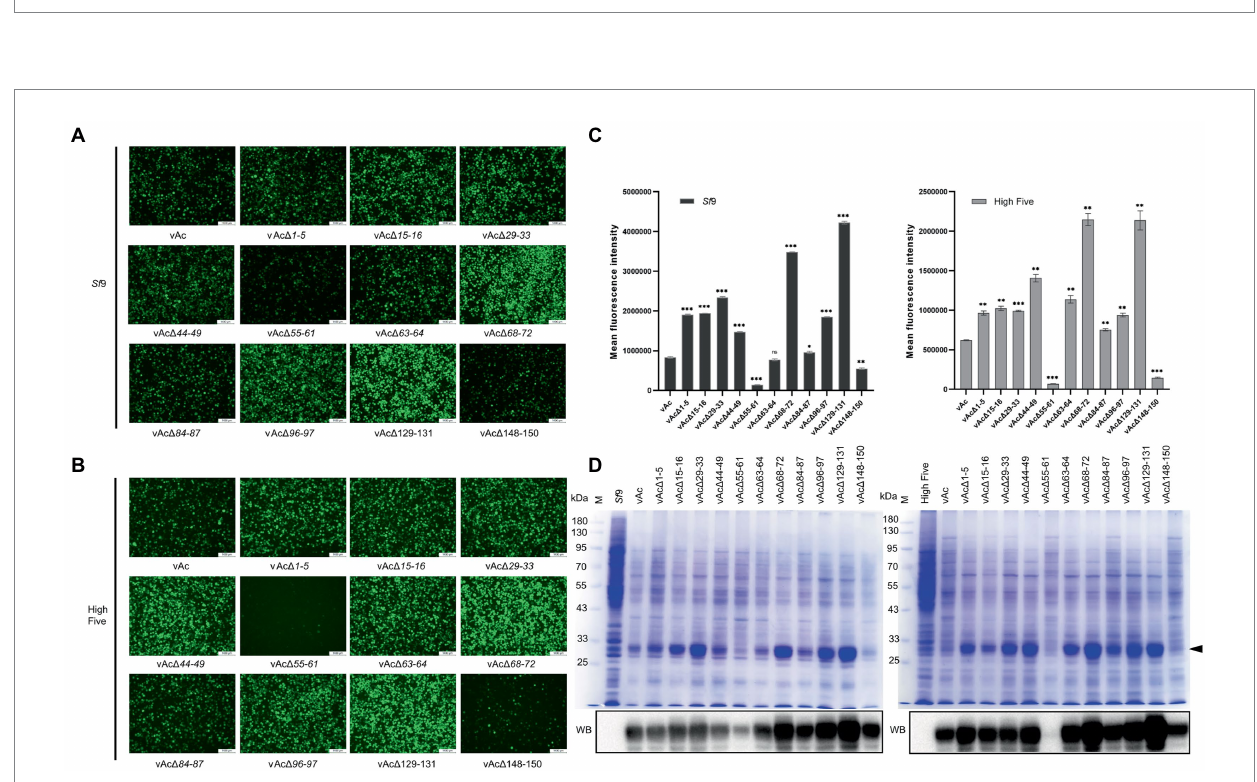
FIGURE 4 Production of fluorescence protein GFP in Sf 9 and High Five cells. (A) Observation of reporter GFP expression in transfected Sf 9 cells under fluorescence microscope. The cells were infected by the virus at an MOI of 3. (B) Observation of reporter GFP expression in High Five cells infected by the indicated viruses under fluorescence microscope. (C) Mean fluorescence intensity of GFP measured by flow cytometry. Data were collected from 3×10 4 cells for each sample, and presented as the means ±SD of two replicates. ns: not significant, * p < 0.05, ** p < 0.01, *** p < 0.001 vs. vAc. (D) Detection of the GFP protein levels by SDS-PAGE (upper panel) and Western blot (lower panel). The total proteins of the indicated cell lysates were separated by SDS-PAGE and visualized by coomassie brilliant blue R250 staining, and the GFP protein band is indicated by a black arrow. In Western blot analysis, the His-tagged recombinant GFP was probed by an anti-His monoclonal